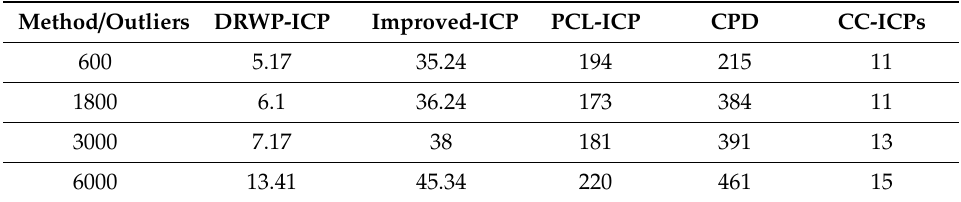
Table 13. Alignment times (seconds).